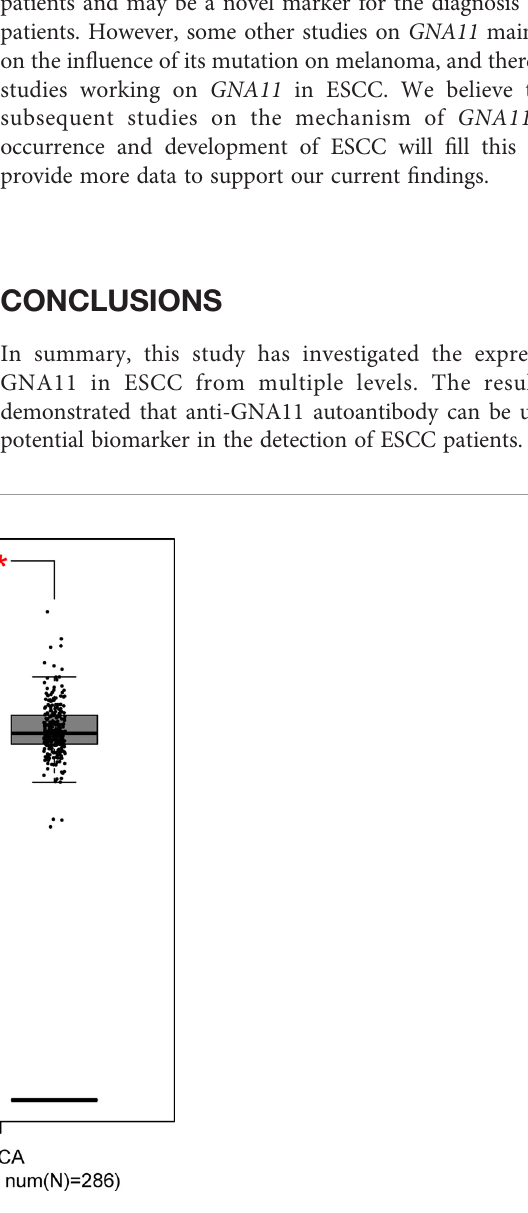
FIGURE 6 | The expression of GNA11 at mRNA level based on TCGA and GTEx data in GEPIA. The red box represents the esophageal carcinoma group, and the gray box chart indicates the normal control group. ESCA, esophageal carcinoma; TCGA, The Cancer Genome Atlas; GTEx, Genotype-Tissue Expression; GEPIA, Gene Expression Pro fi ling Interactive Analysis. * p <